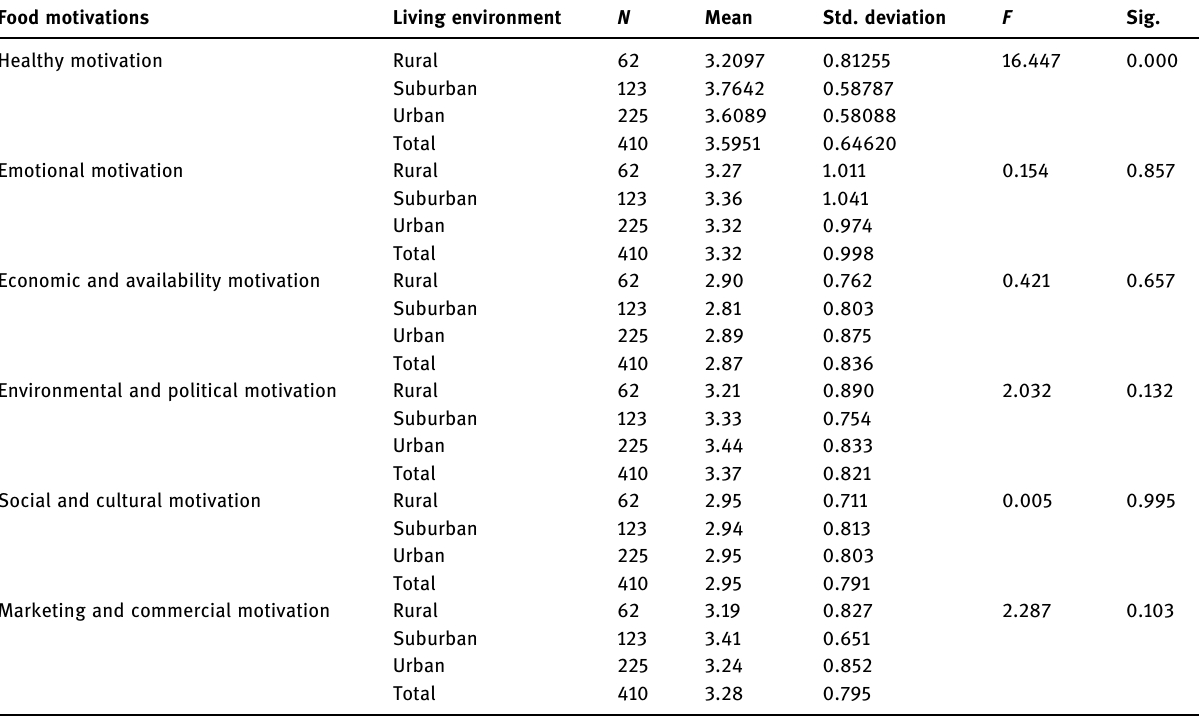
Table 5: ANOVA and mean results of living environment and food motivation